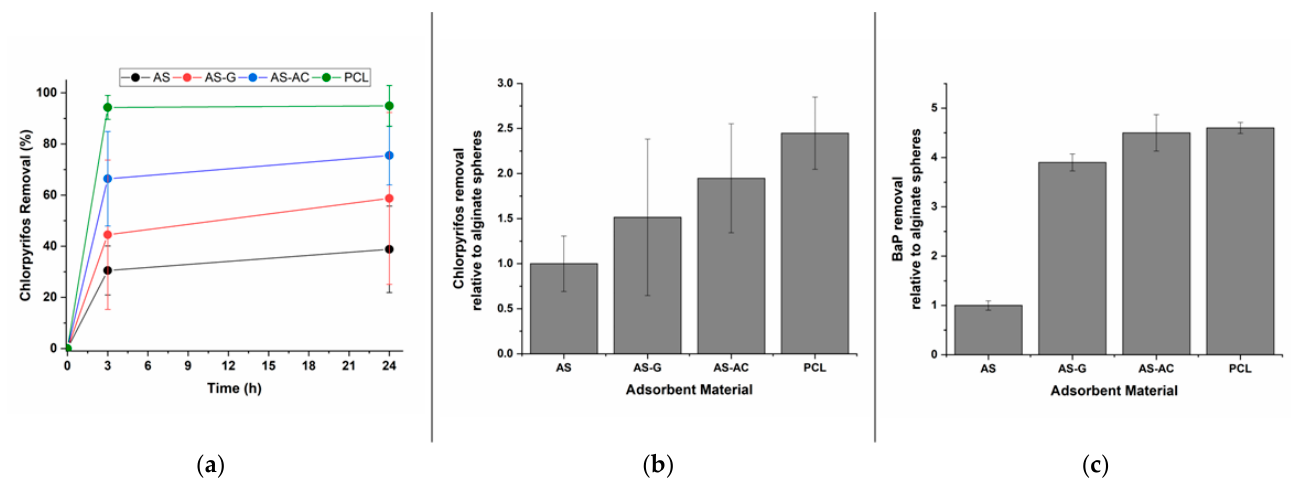
Figure 3. Removal of chlorpyrifos and BaP from aqueous solutions by the different adsorbent materials: alginate spheres (AS), alginate spheres with graphene (AS-G) or with activated carbon (AS-AC), and polycaprolactone microparticles (PCL). ( a ) Kinetics of the removal of chlorpyrifos; ( b ) Comparison of the efficiency of removal of chlorpyrifos by the different materials, relative to the removal provided by AS, in 24 h assay; ( c ) Comparison of the efficiency of removal of BaP by the different materials, relative to the removal provided by AS, in 24 h assay. The results shown are the mean ± SE from triplicate experiments.